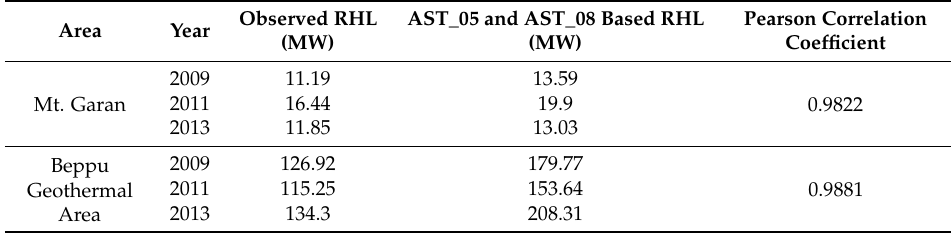
Table 5. Comparison between observed and ASTER standard products base heat loss from both study